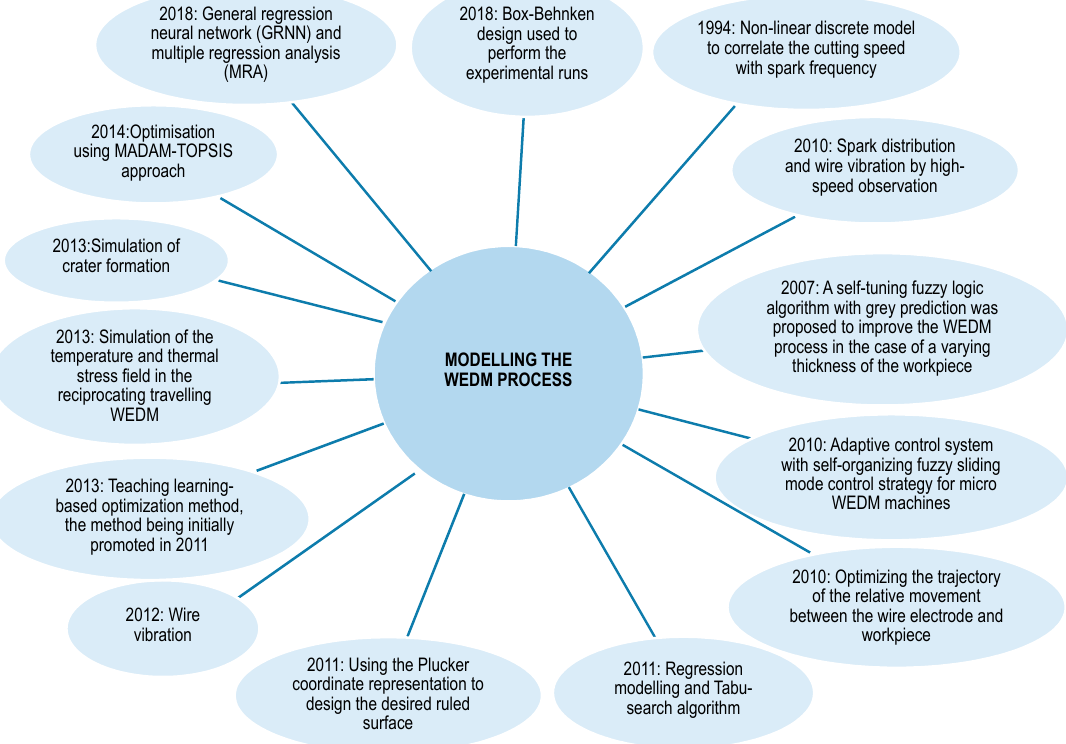
Figure 9. Some of the proposed models for the WEDM process.